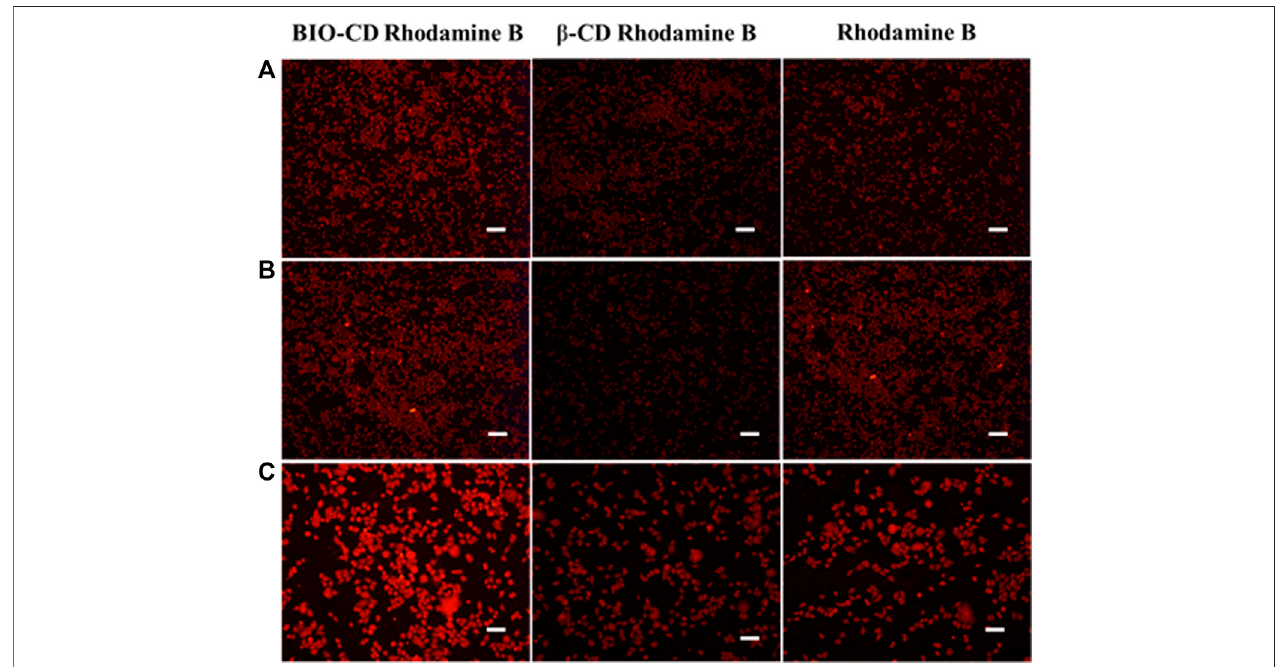
FIGURE 14 | TargetingcellulardeliveryofRhodamineBbyBIO-CD.FluorescenceimagingforcellularuptakeofBIO-CDloadRhodamineBinHepG2,HelaandLO2cells. (A) LO2, (B) HepG2, (C) A549.TheconcentrationsoffreeRhodamineB(20 μ g ml − 1 )andinclusioncomplexmentioned areaspermoleofRhodamineB.Scalebarsare25 μ m.